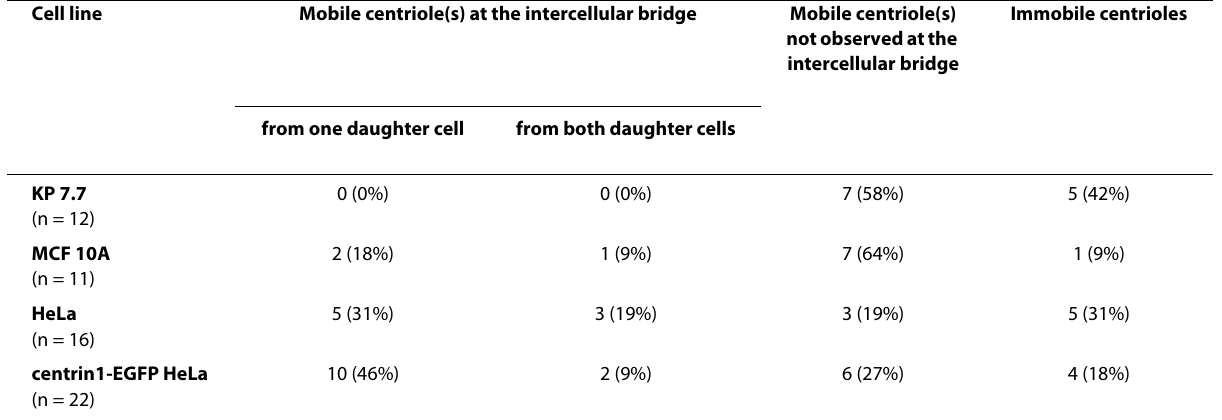
Immobile centrioles not observed at the intercellular bridge